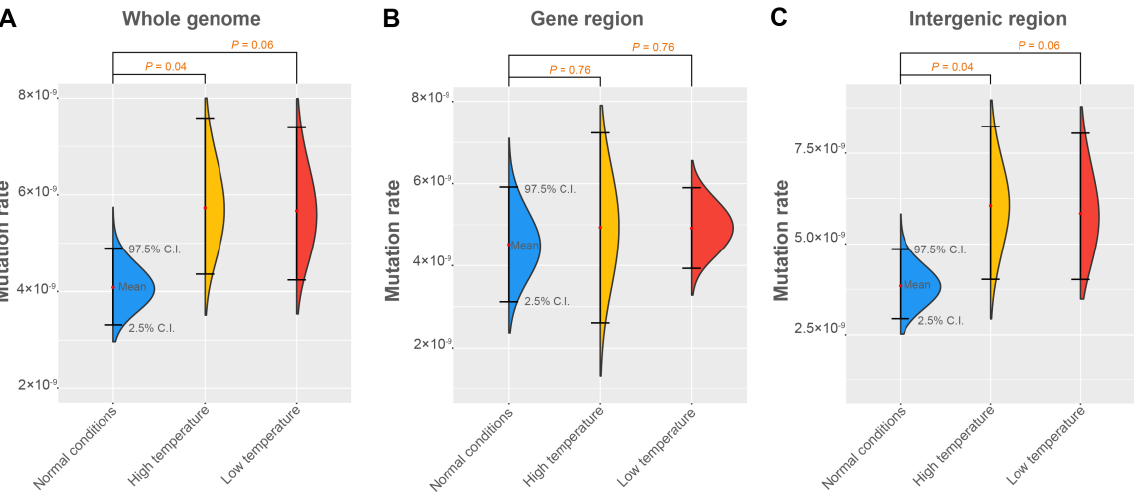
Figure 4. The mutation rates in whole genome, gene region, and intergenic regions of the silkworm under different conditions. The mean value and 95% confidence intervals of the mutation rate of ( A ) the whole genome, ( B ) gene region, and ( C ) intergenic region were shown. The 95% confidence interval of the mutation rate was estimated using bootstrap method with 1000 bootstrap estimates. Student’s t -test was used to evaluate the difference in the mutation rate between each stress-inducing family and normal condition family, and p-value is shown at the top of the figure. The data for the test of significance are the observed mutation rates (per genome) rather than the bootstrap